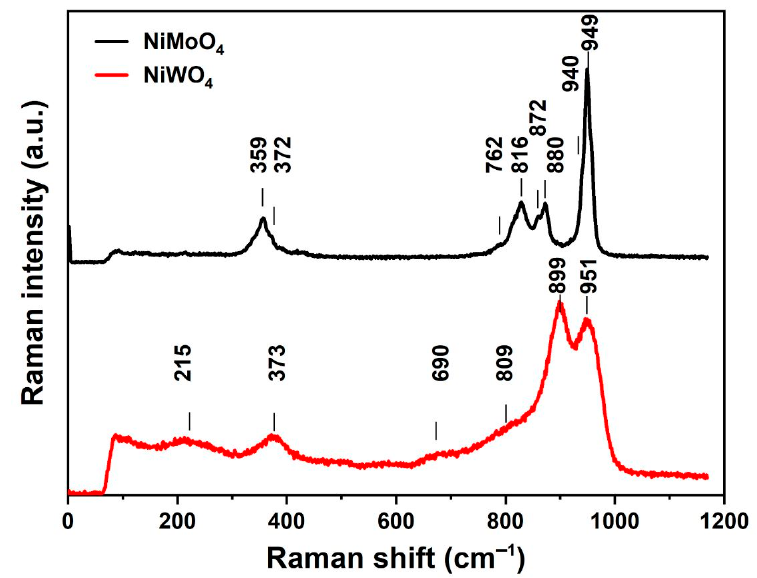
Figure 4. Raman spectra of hydrothermally synthesized NiMoO 4 and NiWO 4 .